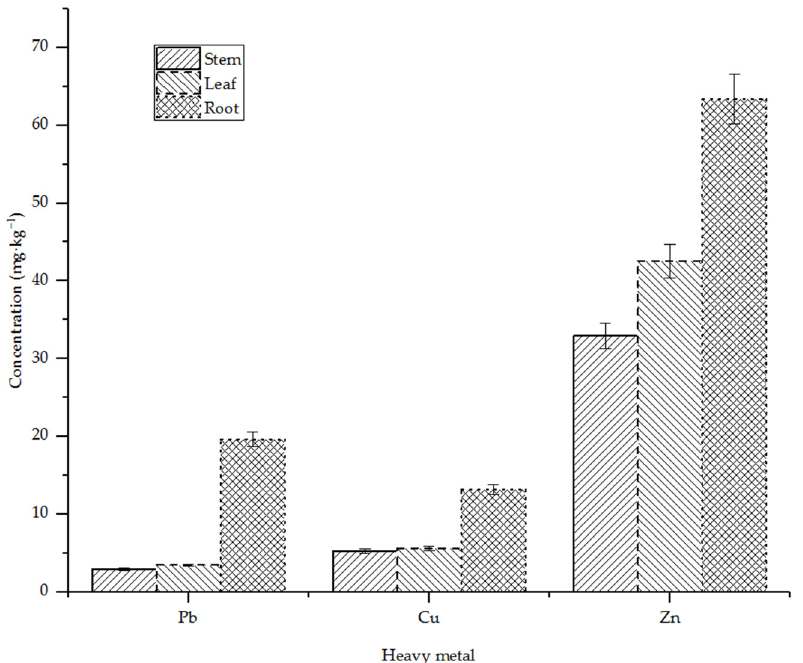
Figure 3. Absorption of heavy metals by Suaeda salsa in the Liaohe estuary wetland.